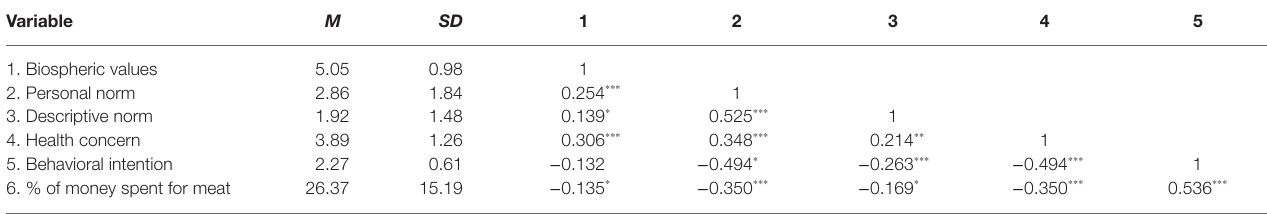
TABLE 3 | Descriptive statistics and correlation coefficients of Study 2. Variable